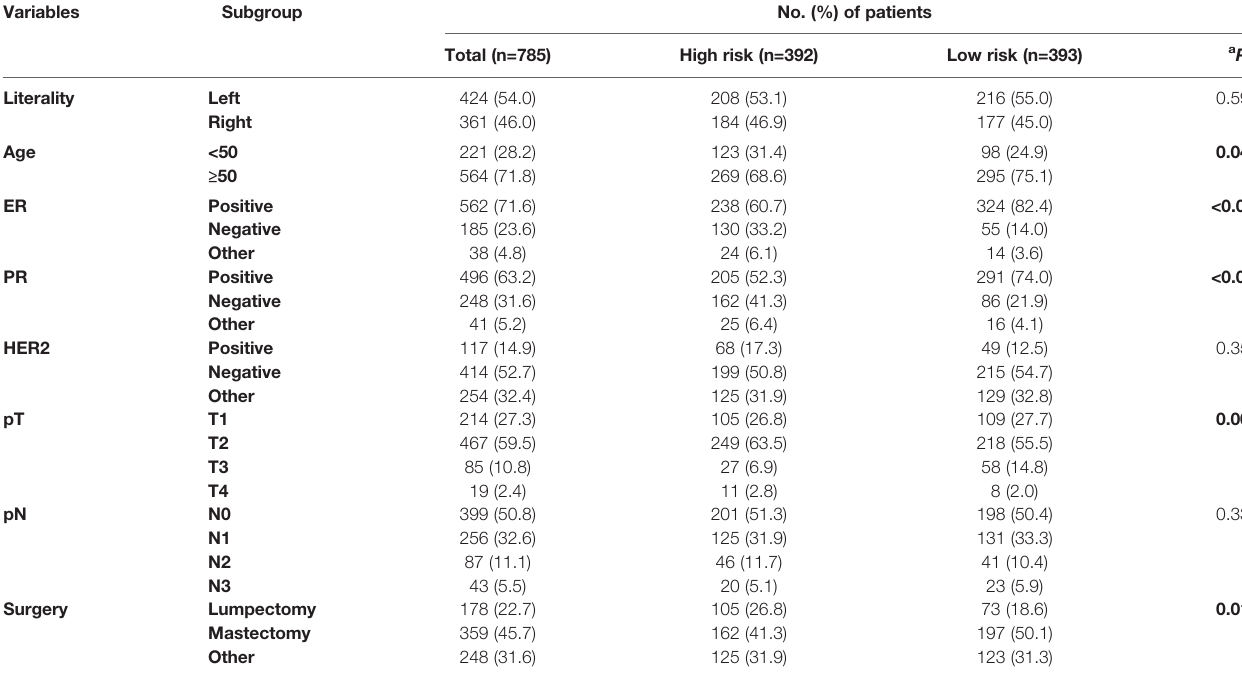
ER,Estrogenreceptor;PR,Progesteronereceptor;HER-2,Humanepidermalgrowthfactorreceptor-2;pT,pathologicallydiagnosedtumorsize;pN,pathologicallydiagnosedlymphnodestatus. a Pearson ’ s Chi-squared test. Bold values indicate statistical signi fi cance